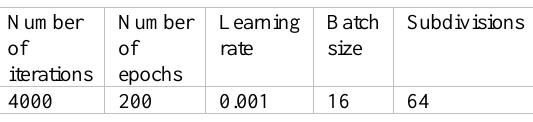
Table 1 . Hyper-parameters to train the Yolo model.